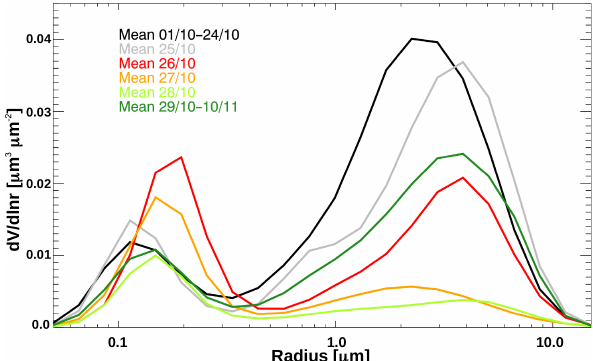
Figure 12. Aerosol size distributions (volume distribution, in µm 3 µm − 2 ) at Lampedusa for some selected periods before, during and after Mount Etna’s eruption of 25–28 October 2013. The aver- age from 1 to 24 October (black line), 25 (grey line), 26 (red line), 27 (orange line), 28 (light green line), 29 October to 10 November (dark green line) are